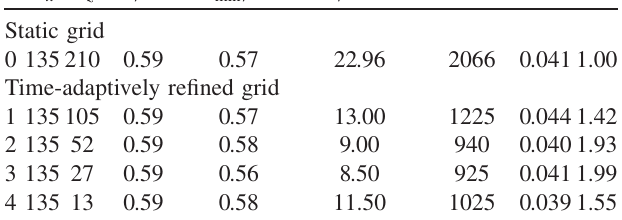
TABLE II. Results of FIT simulations: The top data row lists results obtained on a static, equidistant grid. Below, results obtained on time-adaptive grids using slope-limited Akima splines are displayed.